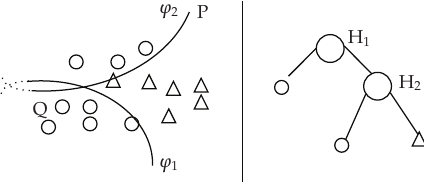
Figure 4: One particular type of QSS tree for D (cid:8)